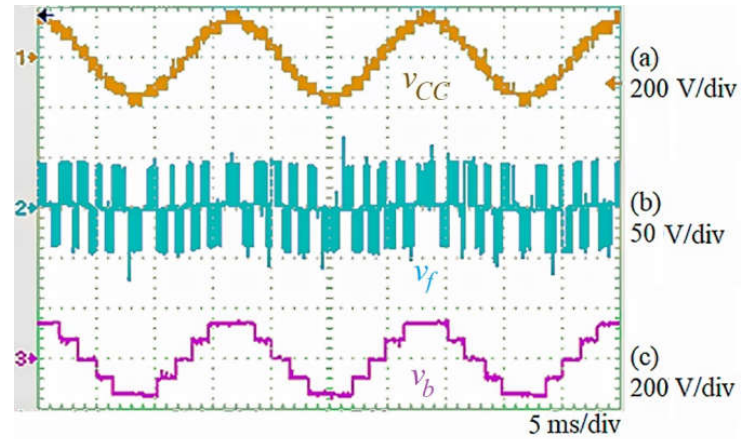
Figure 15. Experimental results for the voltage at the AC side of the CC: ( a ) AC port voltage of CC; ( b ) AC port voltage of FBC; ( c ) AC port voltage of BLR.